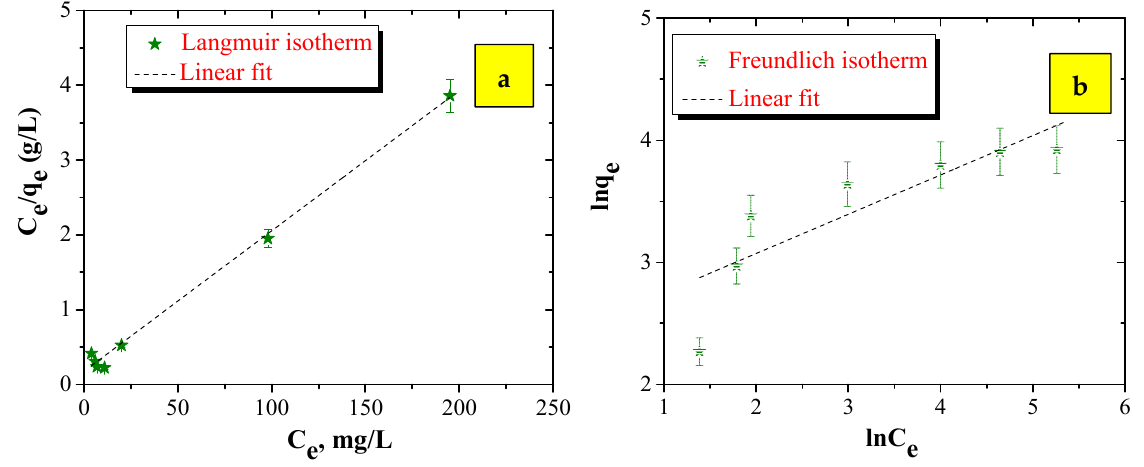
Figure 5. Langmuir ( a ) and Freundlich ( b ) isotherm plots for the adsorption of Cu 2+. The values of the parameters corresponding to each isotherm model are summarized in Table